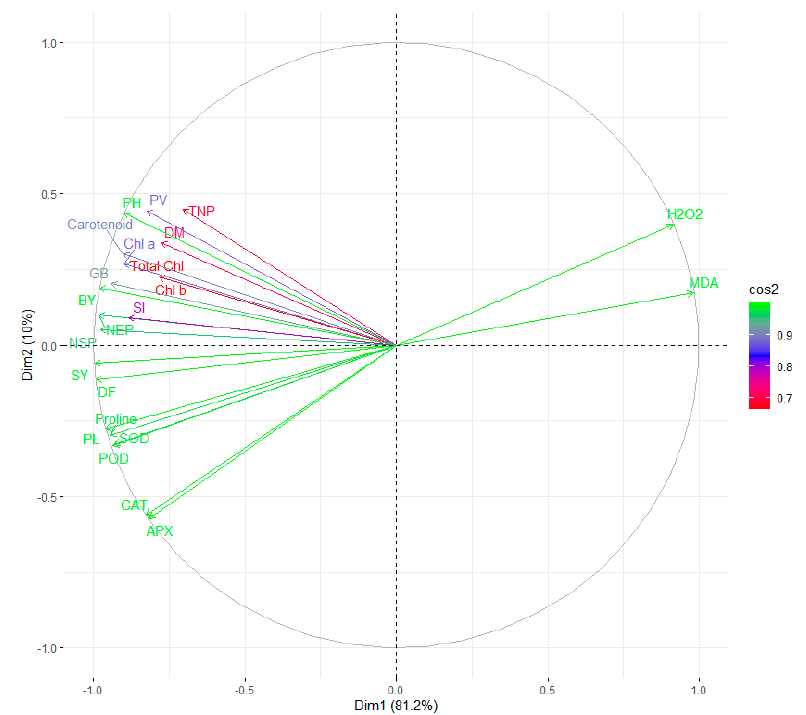
Figure 15. Biplot of different characters of field pea using PC1 and PC2 under heat stress condition.